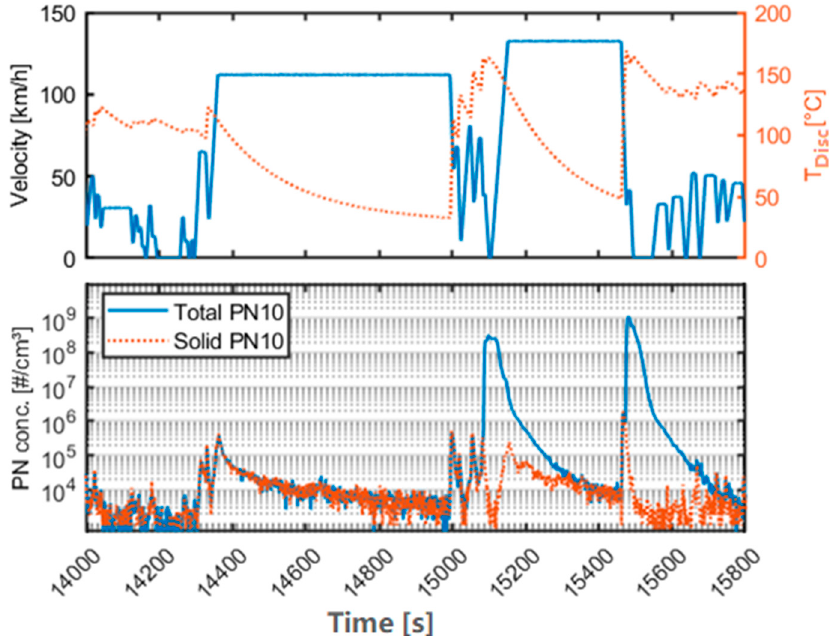
Figure 6. Top: velocity and disc temperature. Bottom: total and solid PN concentration during emission run 1 of Lab T for Br1Fa. The TPN emissions increased during high temperature/high speed stops at the end of WLTP Brake Trip 10.